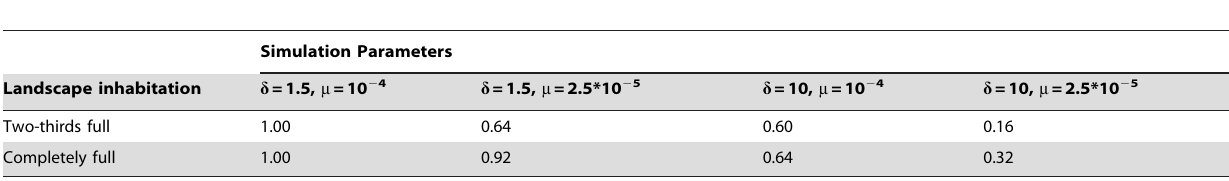
Table 1. Proportion of 25 simulated range expansion event replicates where a significant negative correlation at the a = 0.05 level was observed between landscape coordinates along a South to North transect and pairwise genetic